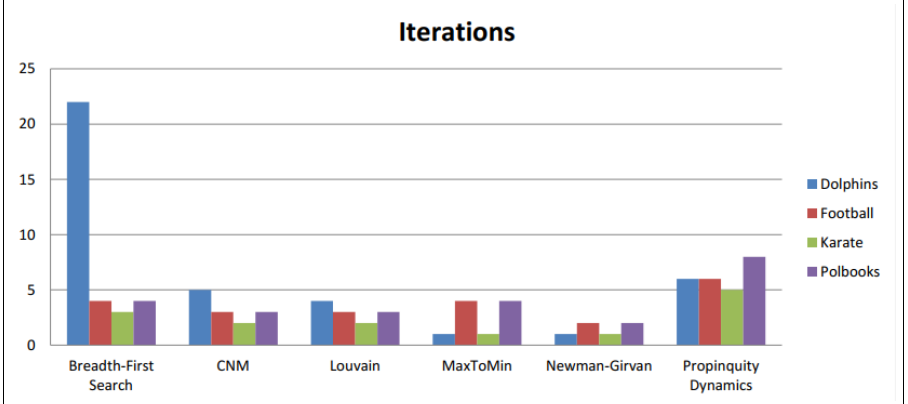
Figure 2. Graphical representation of the number of iterations.